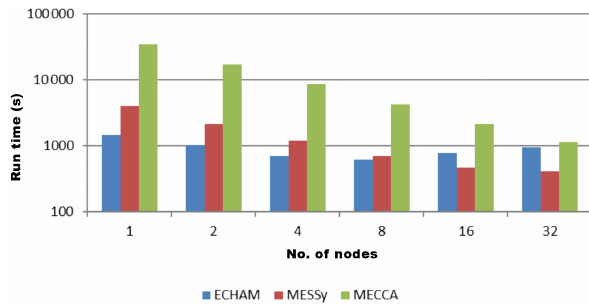
Figure 5. Run time of each phase of EMAC, when running on MareNostrum 3.